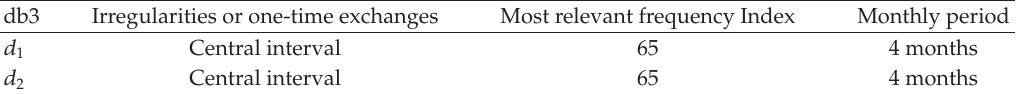
Table 2: First assumption. Relevant frequency indices of Spain INDEX after first period added in the sensitivity analysis.